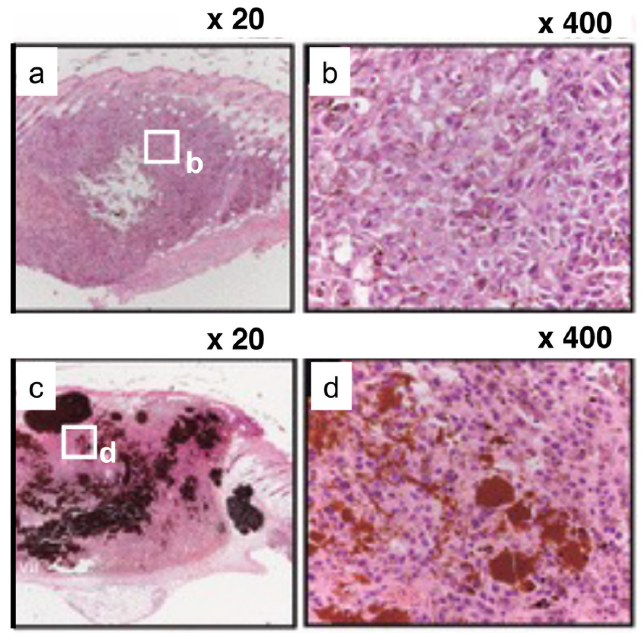
Figure 6. Antitumor effect by magnetic hyperthermia using NPrCAP/M. Pre-established subcuta- neous B16-OVA tumors without treatment ( a , b ) or magnetic hyperthermia using NPrCAP/M ( c , d ) were harvested and analyzed histologically using H&E-stained sections [101]. On Berlin blue staining, brown–black pigments were found to be magnetite particles [27].